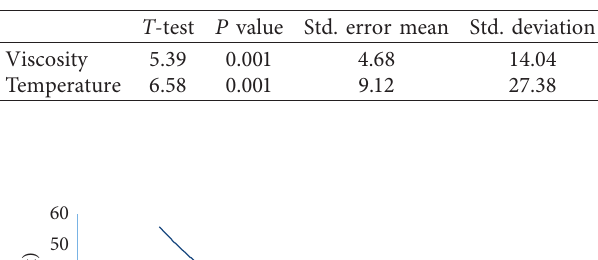
Table 2: Statistical test of viscosity of Jatropha oil and temperature.